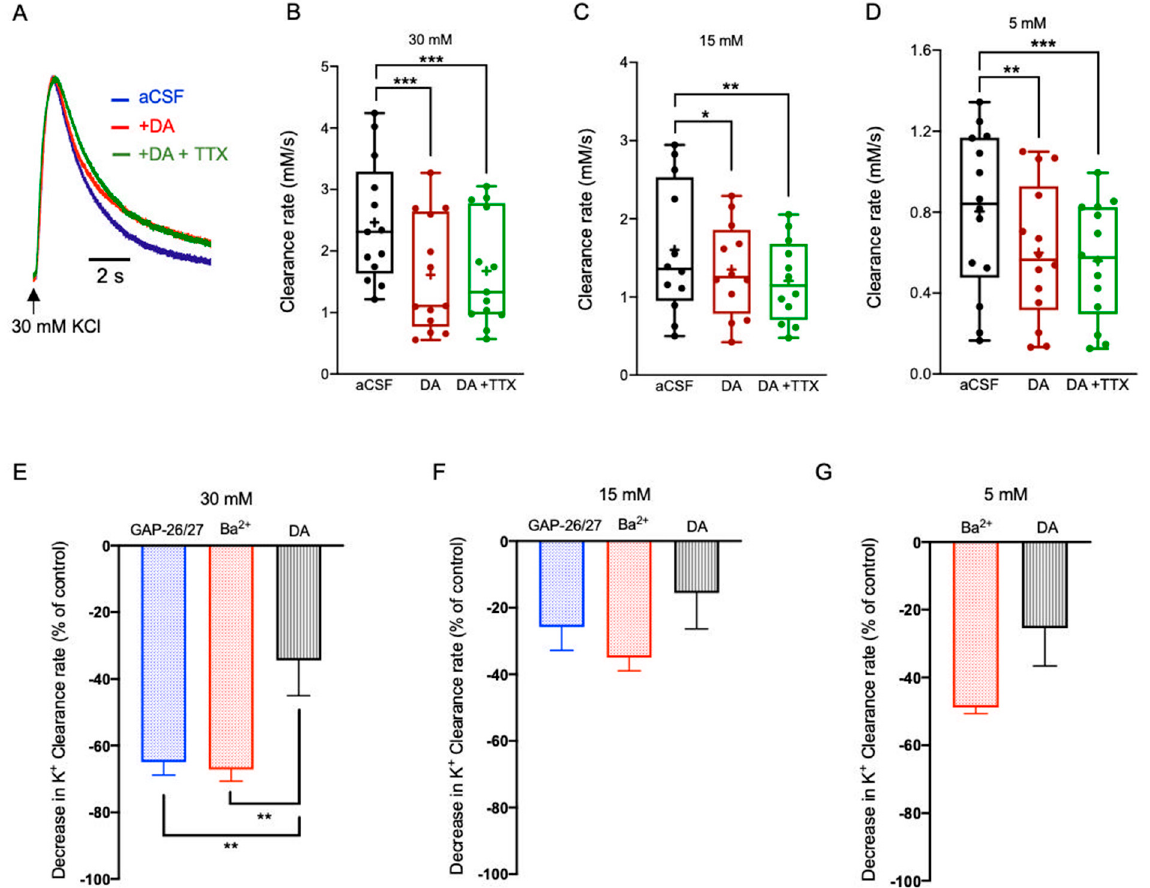
Figure 4. The impact of DA on the K + clearance rate and astrocytic Ca 2+ signaling. ( A ) Sample traces of [K + ] o recordings depicting the K + clearance time course following local application of 30 mM KCl (arrow), before (aCSF, black) and after focal photolysis of 30 µ M caged Dopamine (DA, red) or 30 µ M caged DA with 1 µ M TTX (green). ( B –D) Box plots depicting the K + clearance rate following local application of KCl at 30 mM ( B ), 15 mM ( C ), and 5 mM ( D ), before (aCSF, black dots) and after DA uncaging without (red dots) or with TTX (green dots). ( E – G ) Bar graphs depicting the average decrease in K + clearance rate (as % from control) following blockade of Kir4.1 channels by Ba 2+ (red); blockade of Cx43 channels by a mix of GAP26/27 mimetic peptides (blue), or photolysis of DA (black) together with the local application of 30 mM ( E ), 15 mM ( F ), or 5 mM ( G ) KCl. Box plot definitions is the same as in Figure 1. * p < 0.05; ** p < 0.01; *** p < 0.0001, two-way ANOVA.